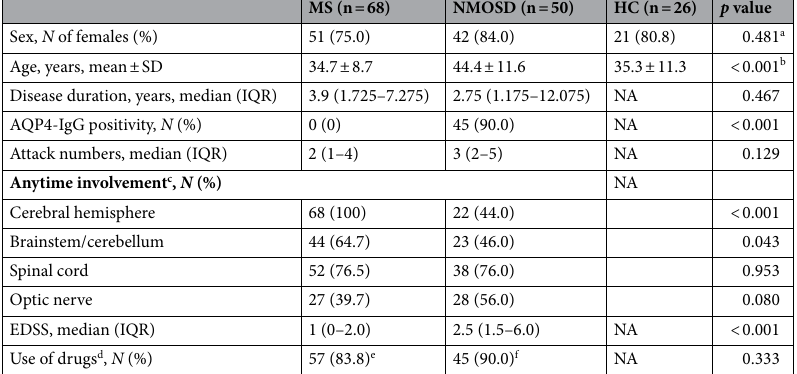
Table 1. Demographics and clinical characteristics of study subjects. MS multiple sclerosis, NMOSD neuromyelitis optica spectrum disorder, HC healthy control, EDSS expanded disability status scale, IQR interquartile range, NA not applicable. a p value from chi-squared test. b p value from ANOVA, posthoc tests results: MS vs. NMOSD ( p < 0.001), HC vs. NMOSD ( p = 0.004), and MS vs. HC ( p > 0.05). c Symptomatic involvement. d Taken at the time of brain MRI. e Interferon β-1b (n = 24), interferon β-1a (n = 11), teriflunomide (n = 8), azathioprine (n = 5), fingolimod (n = 3), glatiramer acetate (n = 3), dimethyl fumarate (n = 2), mitoxantrone (n = 1). f Azathioprine (n = 29), mycophenolate mofetil (n = 12), rituximab (n = 2), cyclosporine (n = 1), methotrexate (n =